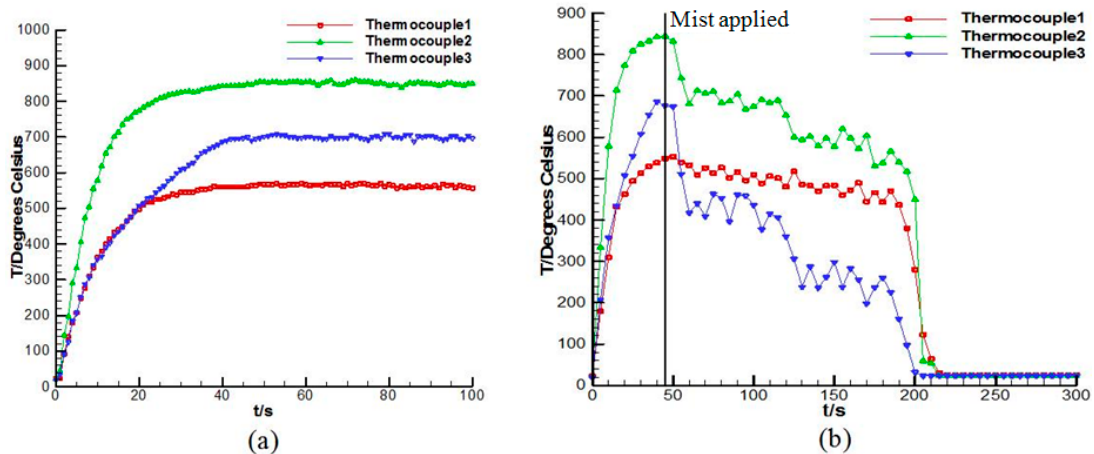
Figure 4. Variation of flame temperature before and after releasing water mist: ( a ) no water mist and ( b ) with water mist.